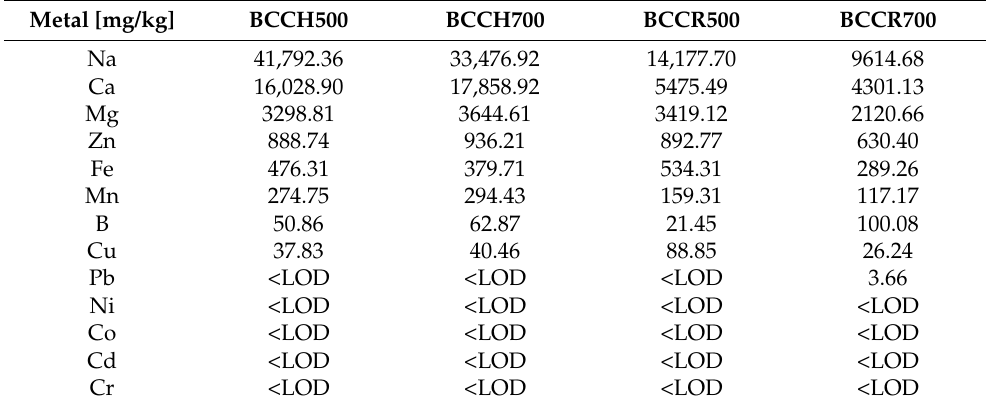
Table 3. Metals (heavy metal: Zn, Cu, Pb, Ni, Co, Cd, Cr and metal mineral nutrients Fe, Na, Ca, Mg, Mn, B) content [mg/kg] in BCs sample.